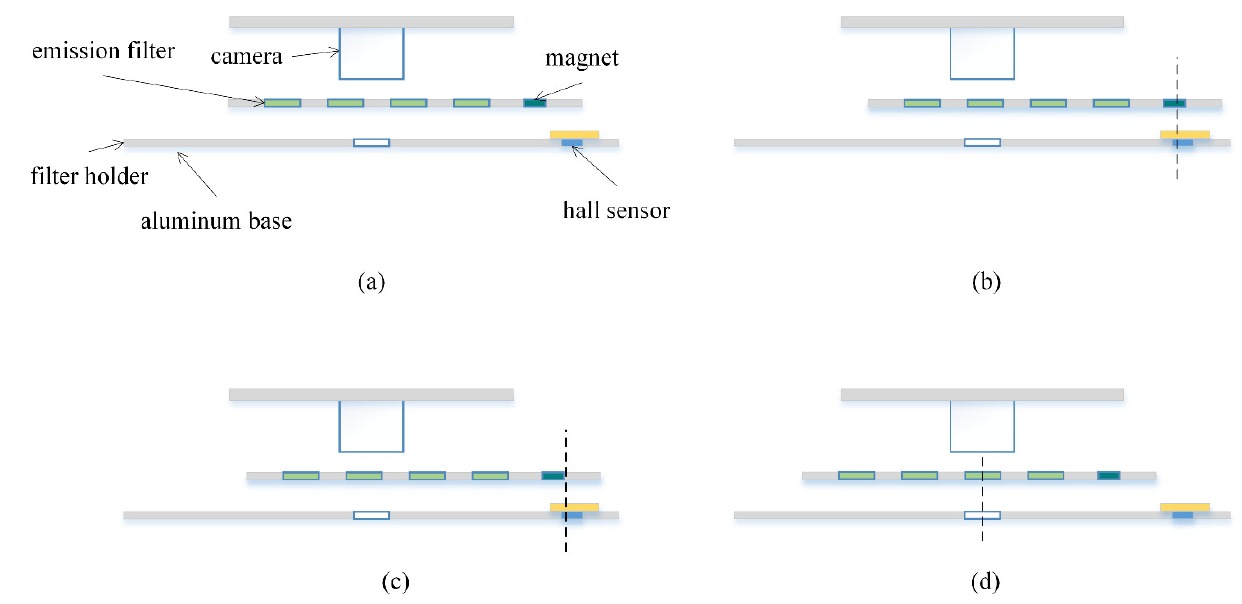
Figure 5. Filter wheel motion. ( a ) Schematic diagram of the filter wheel; ( b ) Coarse search for home position; ( c ) Fine search for home position; ( d ) Aligned filter position.